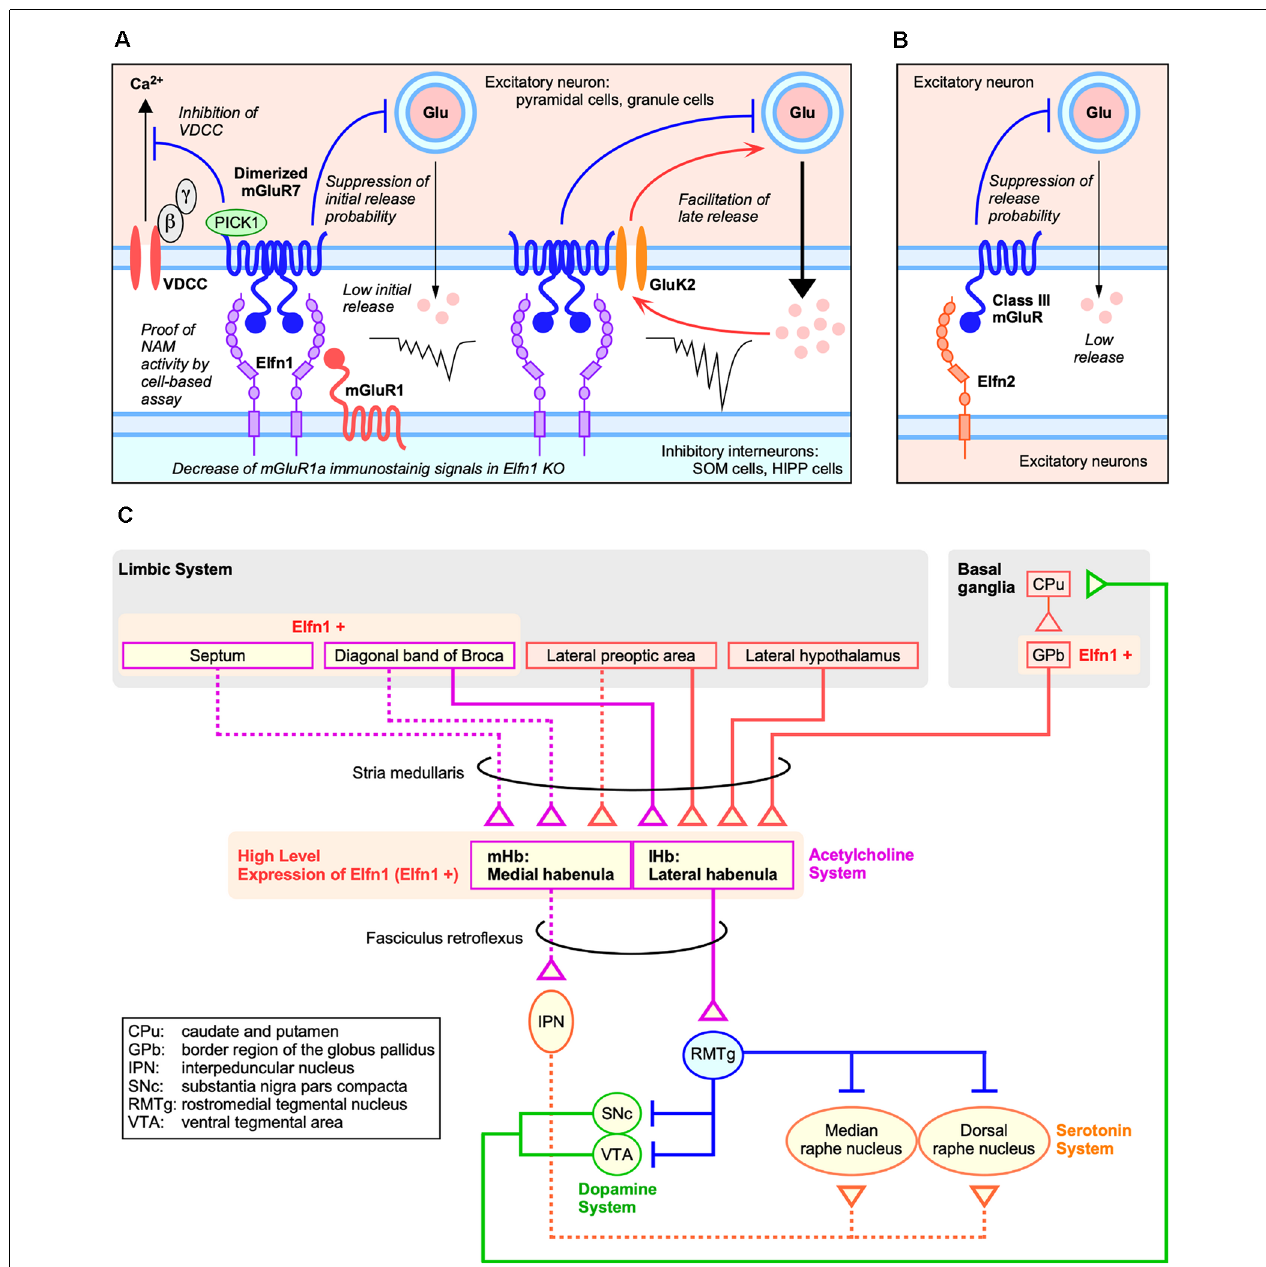
FIGURE 2 | Roles of Elfns–mGluRs trans-interaction in synapses. (A) Roles of Elfn1 in hippocampal and cortical synapses on somatostatin-interneurons (SST-INs). (B) Role of Elfn2 in hippocampal synapses. (C) Dopaminergic and habenular neural circuits for ADHD (Lee and Goto,